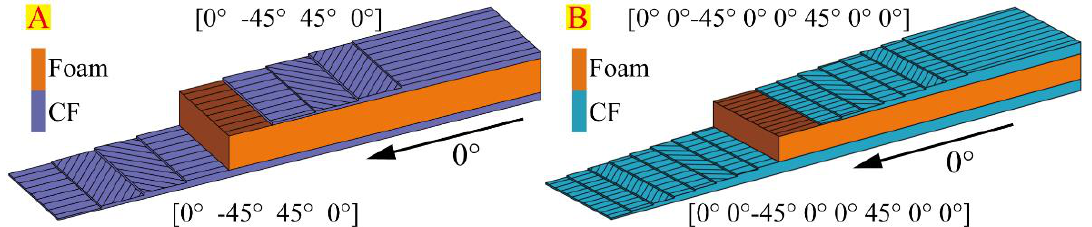
Figure 3. Two types of sandwich panels: ( A ) composite plate; ( B ) reinforced composite plate.